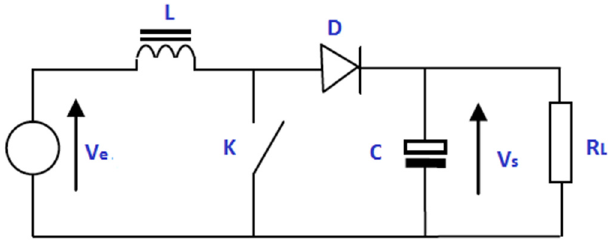
Fig. 5. Electrical structure of the BOOST